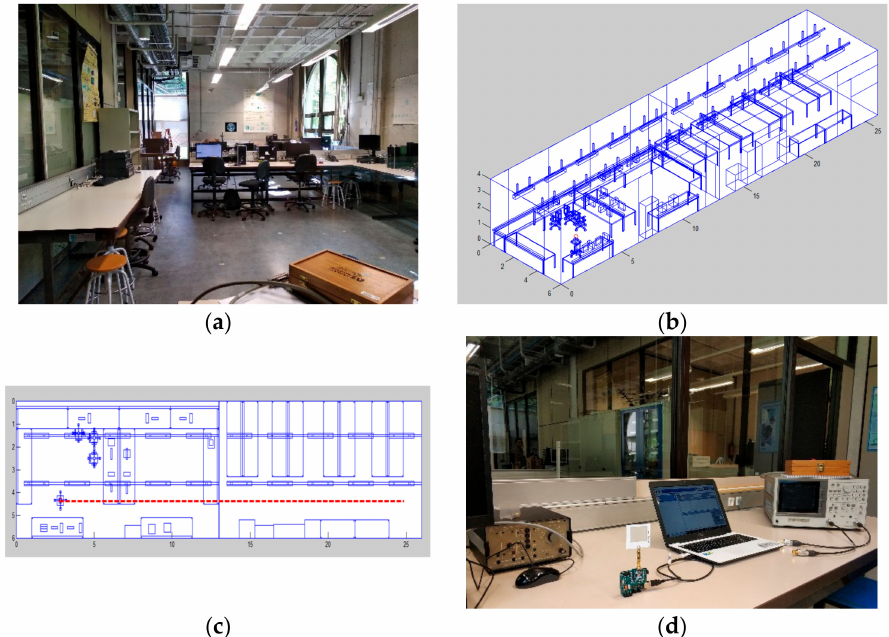
Figure 9. Lab scenario employed for system level validation: ( a ) Real lab environment, ( b ) volumetric scenario implemented in the 3D Ray Launching simulation tool, ( c ) detail of the radial validation layout, and ( d ) detail of the measurements with the ZigBee mote